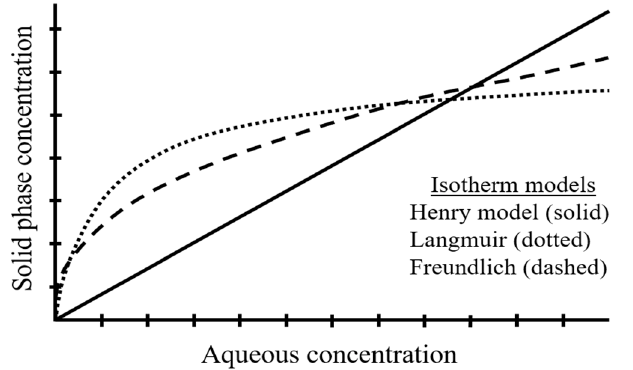
Figure 3. Standard isotherm models used in the study of sorption / desorption of environmental pollutants in MPs.